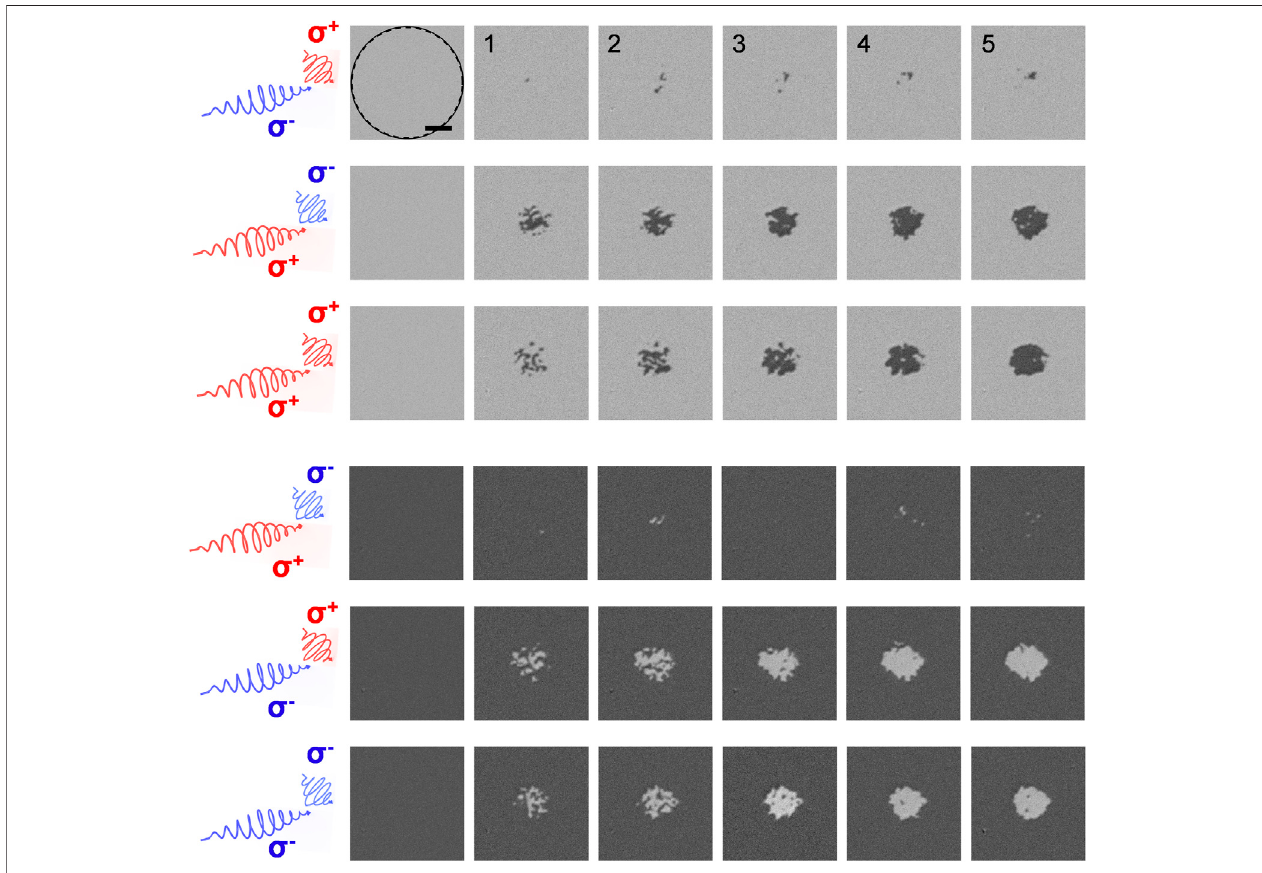
FIGURE 3 | AO-HDS with a combination of 90-fs and 3.0-ps circularly polarized pulses. Snapshots before and after illuminating the uniformly magnetized sample with1 – 5pairsofpulsesat Δ t of5.0 psaredisplayed.Theerrorbarsweredeterminedbyrepeatingthesamemeasurementsthreetimes.Here,weused fl uences F σ 1 =2.35 mJ/ cm 2 and F σ 2 =1.32 mJ/cm 2 forfsandpscircularlypolarizedpulses,respectively.The1/e 2 diameteroftheps(solidline)andfs(dashline)pulseswere84.2±1.2and82.7±1.0 μ m, respectively. The scale bar corresponds to 20 μ